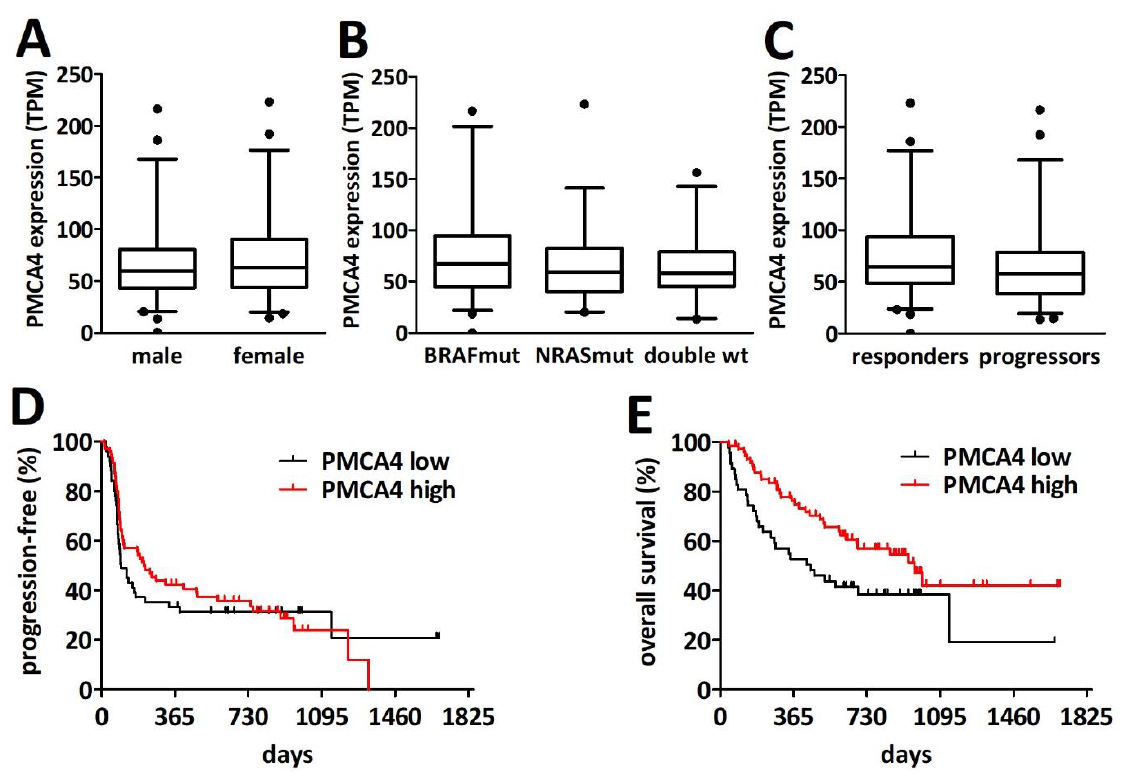
Figure 7. PMCA4 is a prognostic factor in PD-1 inhibitor treated melanoma patients. ( A ) There is no difference in the distribution of PMCA4 transcript levels between male (n = 71) and female (n = 50) patients (TPM — transcript per million). ( B ) There is no significant difference in PMCA4 mRNA levels between BRAF mutant (n = 51), NRAS mutant (n = 34) and double wild type (n = 36) tumors ( C ) PMCA4 levels in responders (n = 65) and in patients with progressive disease (n = 56; p = 0.0677). ( D ) PMCA4 levels showed no significant impact on progression-free survival after PD-1 blockade. € High PMCA4 transcript levels were associated with longer overall survival ( p = 0.0182).